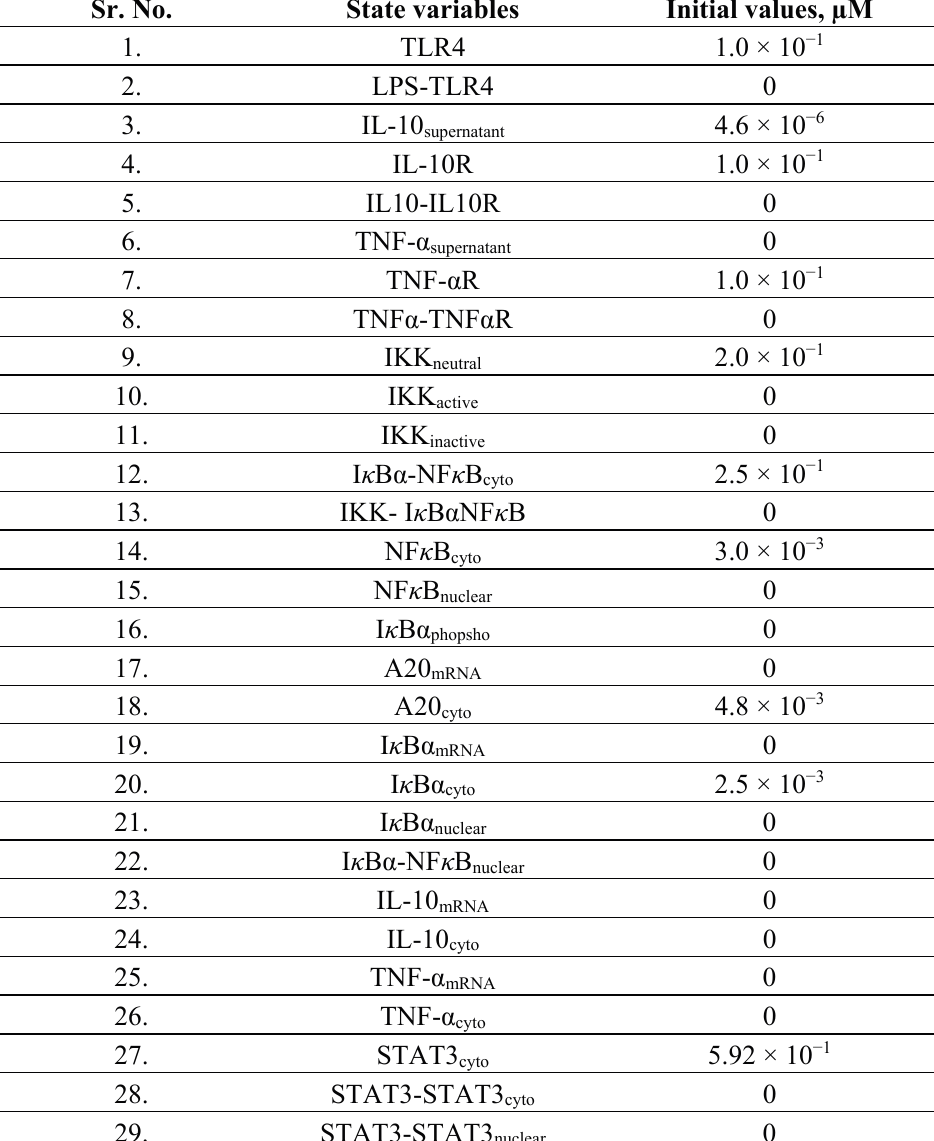
Table 3. State variables and their initial values as used in the ODE model. Sr.